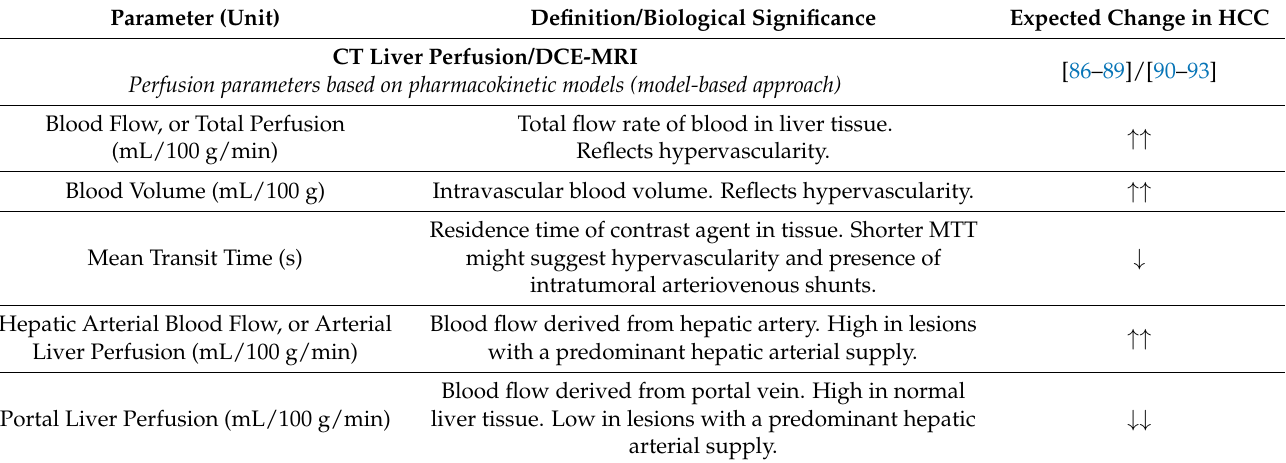
Table 6. Glossary of commonly-reported CT and MRI perfusion parameters alongside expected changes in HCC lesions relative to surrounding liver parenchyma. Number of arrows indicates the magnitude of